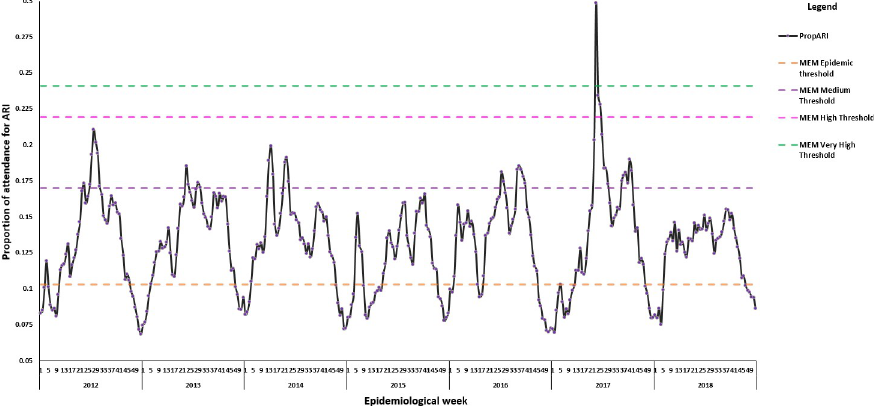
Fig 3. Time-series for the two wave/season curve of the proportion of attendance for ARI using MEM, Mauritius, season 2012–2018.